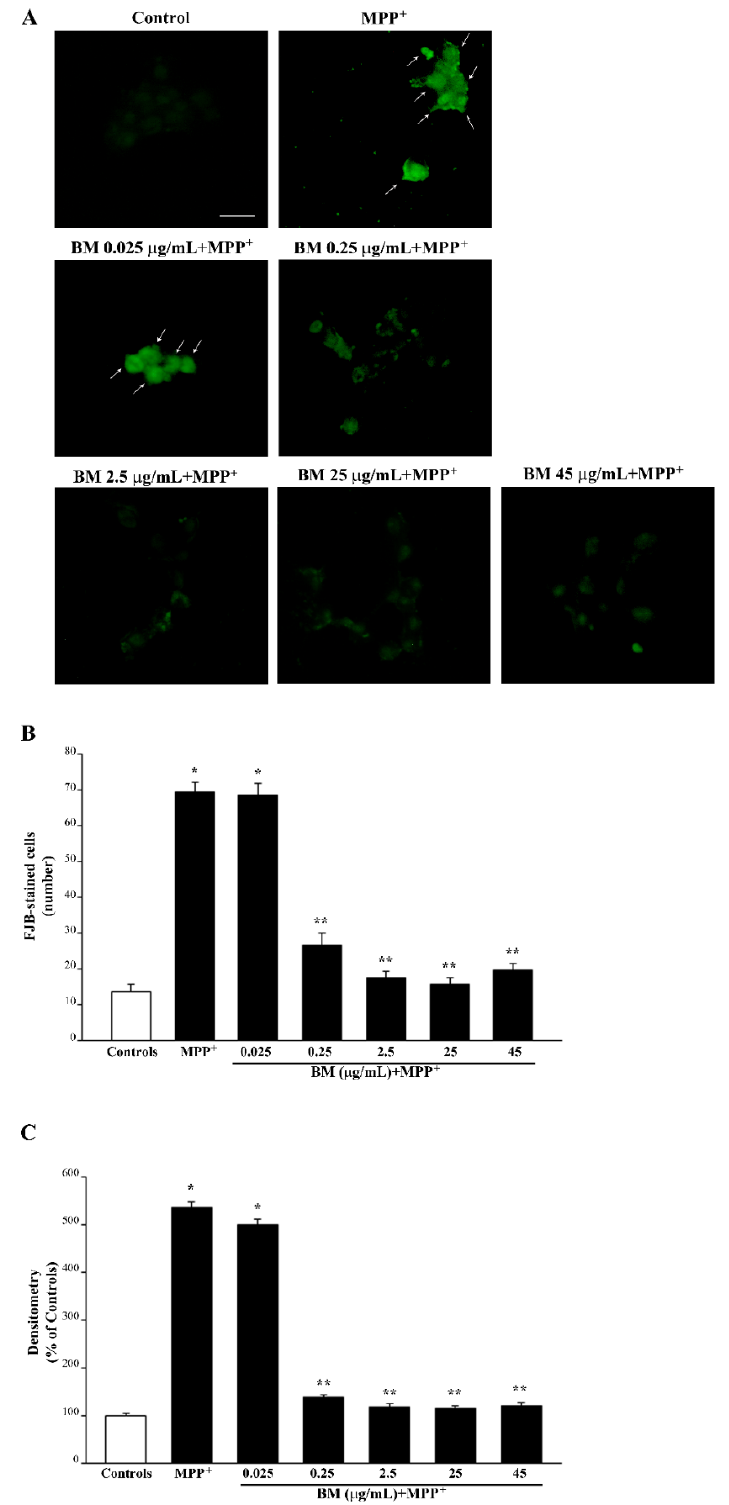
Figure 6. BM decreases MPP + -induced FJB staining of PC12 cells. ( A ) Representative pictures of FJB-stained cells after MPP + (100 µ M) alone or in combination with various doses of BM (from 0.025 µ g/mL up to 45 µ g/mL). Arrows indicate cells intensely stained with FJB. Graphs report either number ( B ) or intensity ( C ) of FJB fluorescent cells. Values are given as mean ± S.E.M. ( A ) or the mean percentage ± S.E.M. (assuming controls as 100%, ( B )) of cells counted from three independent experiments. * p < 0.05 compared with controls; ** p < 0.05 compared with MPP + . Scale bar = 12 µ